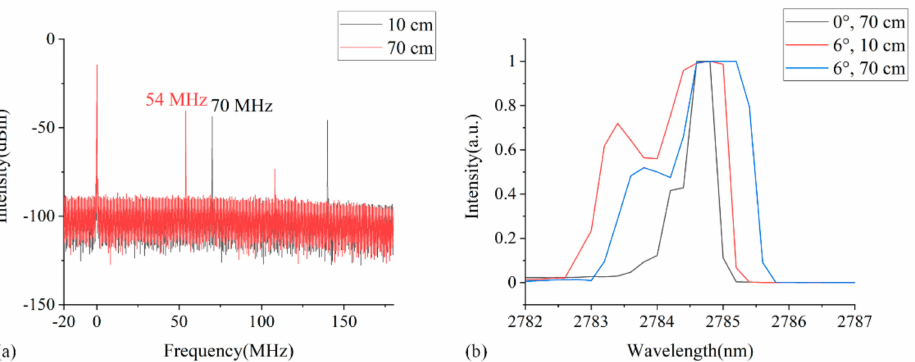
Figure 8. ( a ) Beating spectra at RF under different distances between the grating and the right fiber end-face. The fiber end-face is cleaved at 6 ◦ . ( b ) Optical spectra around 2784.5 nm when the fiber end-face is cleaved at 6 ◦ under different distances. The case of the perpendicularly cleaved fiber end-face is also shown for